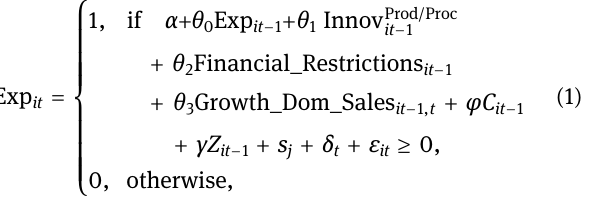
According to the results presented in Table A2 ( column 1: original annual data ) from the estimation of this auxiliary equation, the probit model of fi rms ’ survival versus death, we see that for SMEs, exporting, being more productive or introducing innovations ( mainly process innovations but also product ) increase their likelihood of survival. Conver - sely, SMEs that su ff er more fi nancial restrictions, face a more recessive market situation, pay higher wages per worker, have a higher share of temporary workers, or su ff er a greater increase in the prices of their intermediate inputs reduce their chances of survival. As expected, a lower uti - lization of the fi rms ’ productive capacity reinforces the negative role of the recessive index in fi rms ’